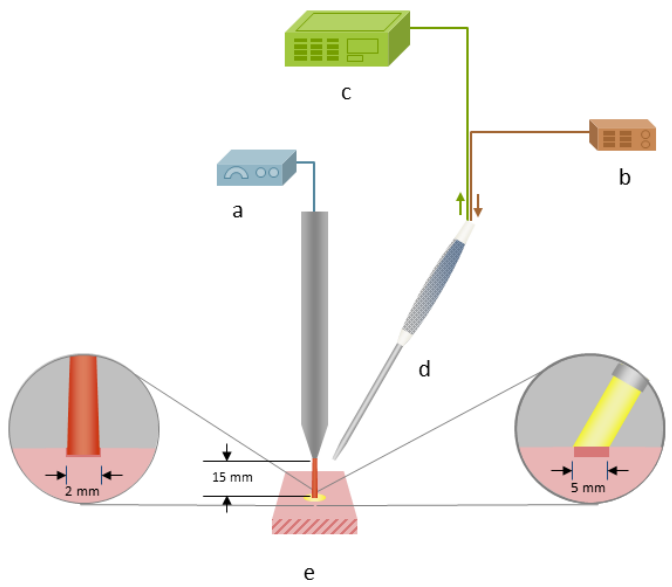
Figure 2. Schematic experimental set-up for laser ablation and optical measurements: ( a ) Er:YAG laser. ( b ) Halogen light source. ( c ) Spectrometer. ( d ) Reflection/backscattering probe. ( e ) Tissue sample ( ex vivo , pig).